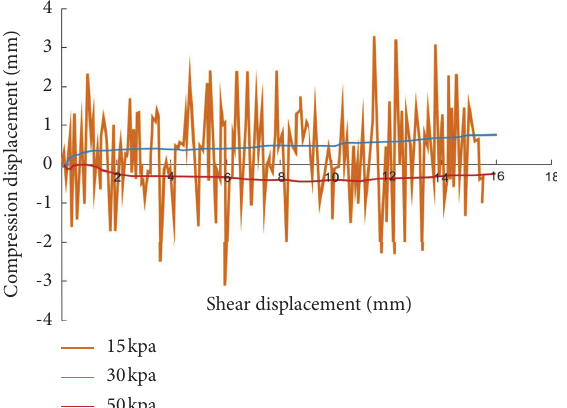
Figure 6: Relationship between compression displacement and shear displacement in nonreinforced sand in the shear